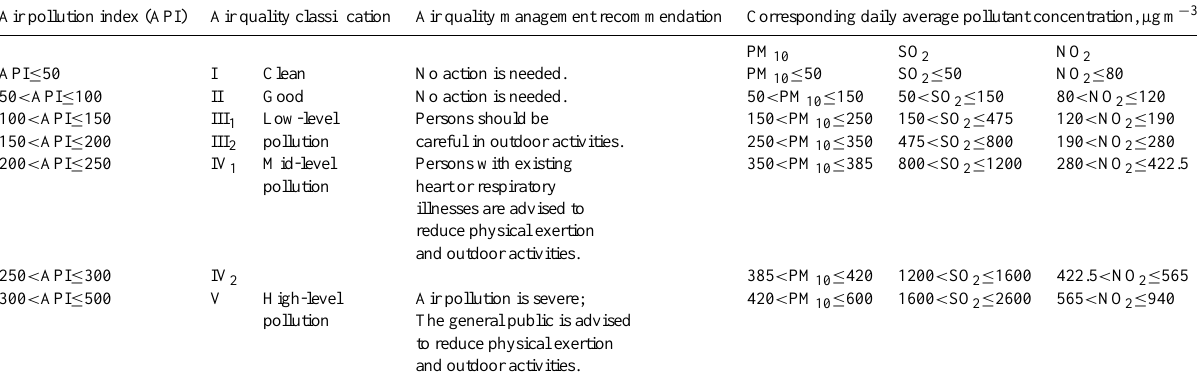
Table 2. Air quality classifications corresponding to the air pollution indexes (APIs), air quality management recommendations, and pollutant concentrations in China.